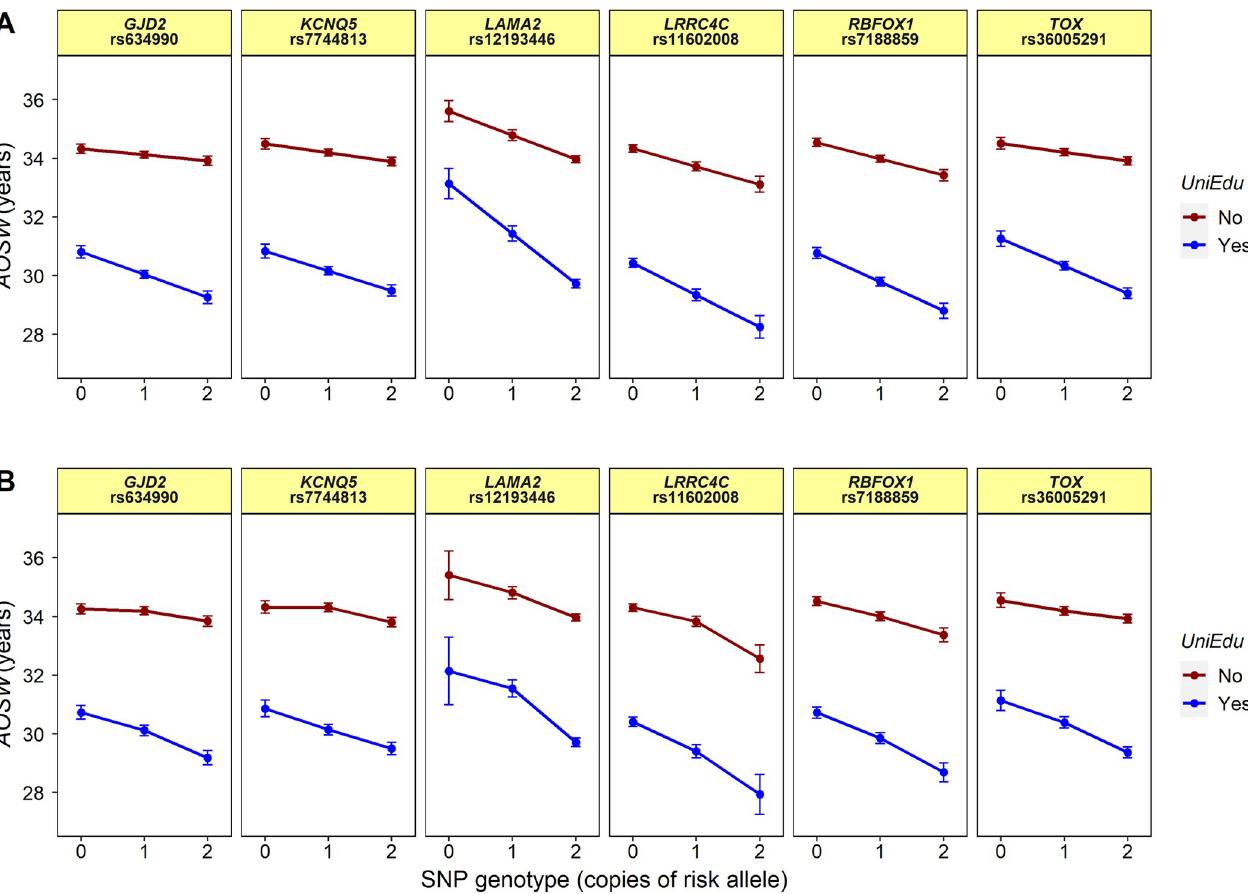
Fig 4. Modeling genotype-by-education interactions when allowing for dominance effects. The plots illustrate the relationship between SNP genotype, exposure to University education ( UniEdu ) and the AOSW phenotype in the Stage-II sample when SNP genotypes were coded as either numeric (i.e. assuming additive effects; panel A) or categorical (allowing for dominant or recessive effects; panel B).